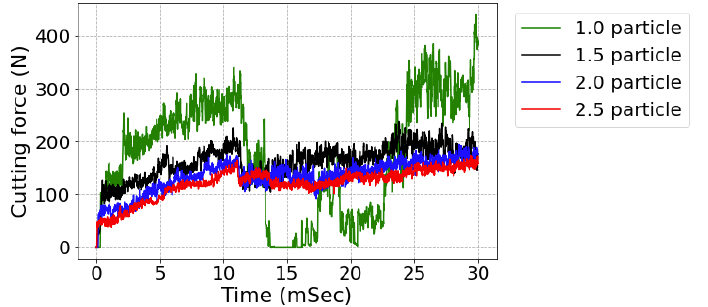
Figure 10. Plot for cutting force predicted by 3D machining model with different SPH particle density. This is done to achieve mesh